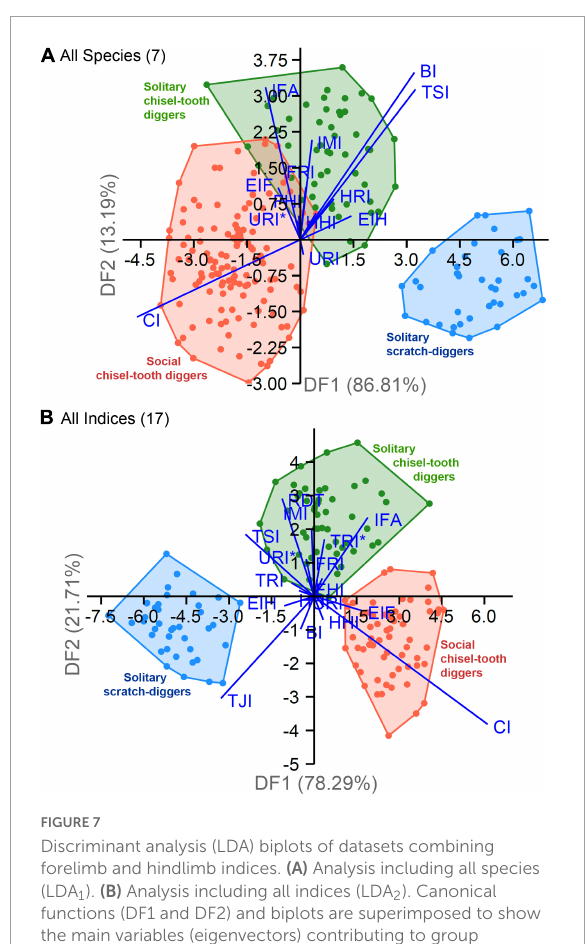
FIGURE7 Discriminant analysis (LDA) biplots of datasets combining forelimb and hindlimb indices. (A) Analysis including all species (LDA 1 ). (B) Analysis including all indices (LDA 2 ). Canonical functions (DF1 and DF2) and biplots are superimposed to show the main variables (eigenvectors) contributing to group discrimination. See abbreviation of indices in Table 2